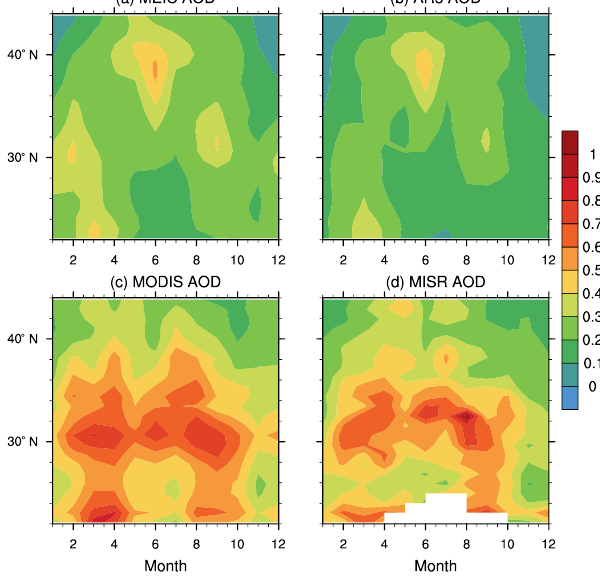
Figure 4. The seasonal variation of longitudinal-average (100– 124 ◦ E) AOD at 550nm over eastern China simulated by CAM5- MAM3 using (a) the MEIC emission and (b) the AR5 emission, and observed by (c) MODIS and (d) MISR satellites in